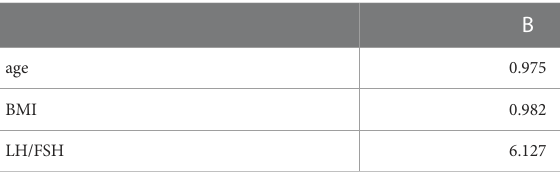
TABLE 5 Corrected for age, BMI for multi-factor binary logistic